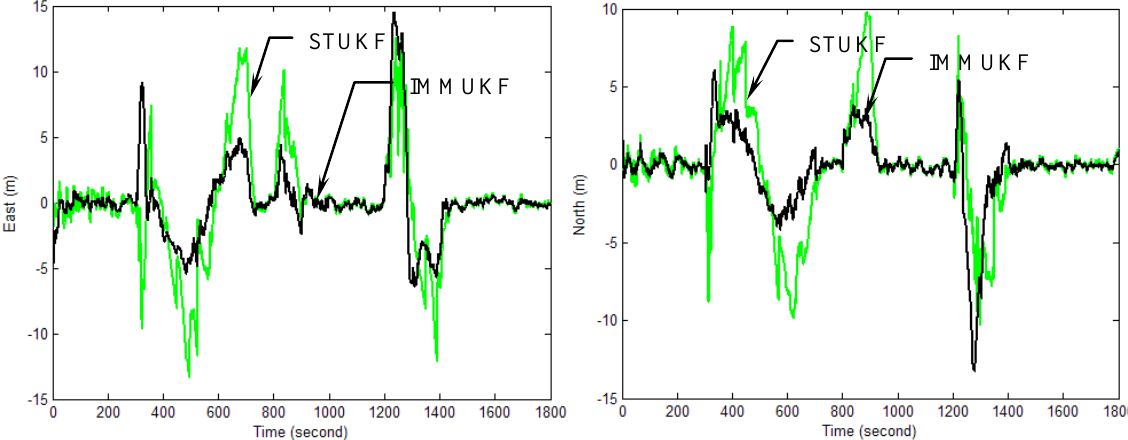
Figure 11. Comparison of the navigation accuracy for IMMUKF and